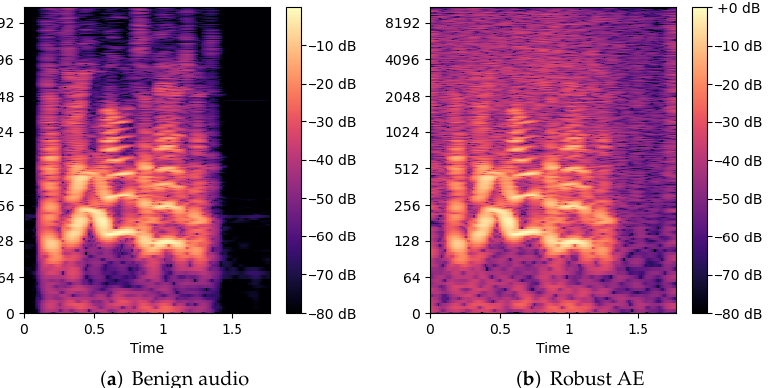
Figure 6. Comparing spectrograms of ( a ) benign audio with ( b ) the robust audio AE. Distortion in the AE is